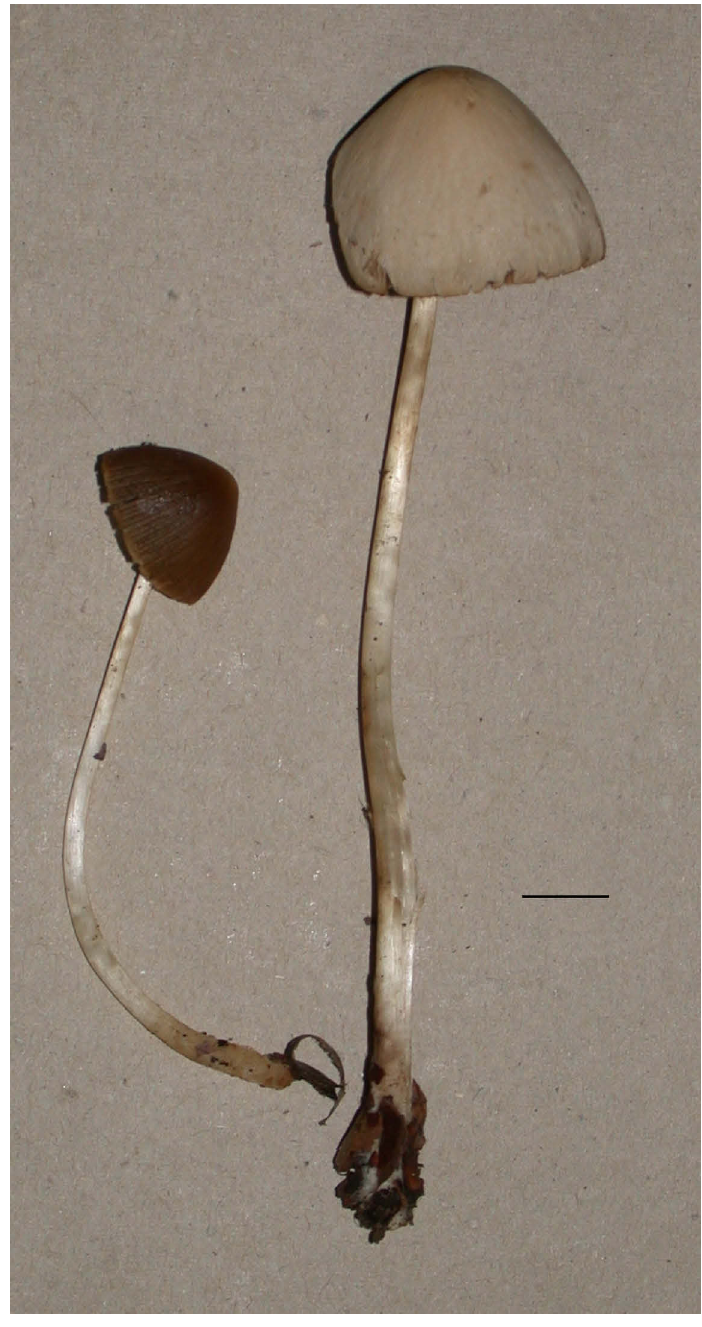
Fig. 3. Psathyrella conopilus (Fr.: Fr.) A. Pear son et Dennis, coll. KRAM F-54148; scale bar = 10